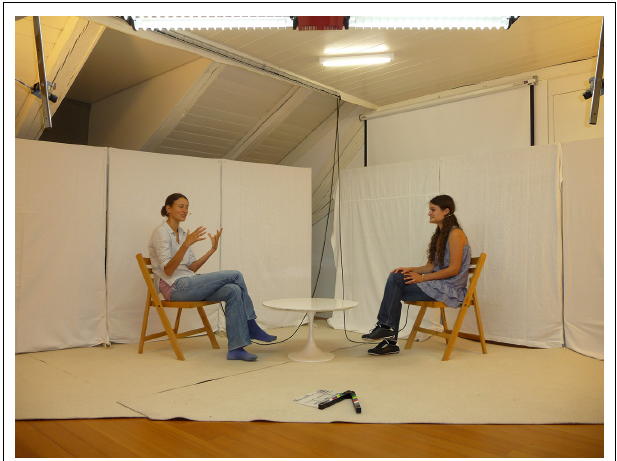
FIGURE 1 | Depiction of the experimental setup. Top left and right, digital video cameras.